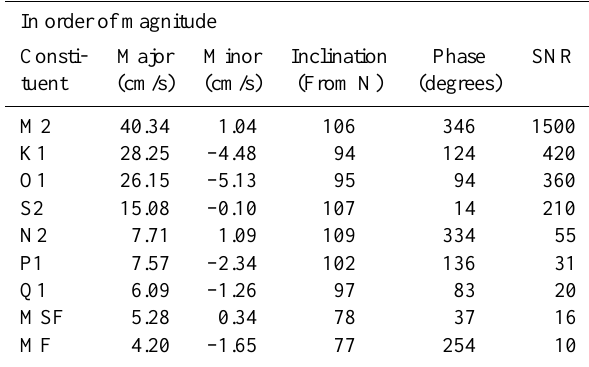
Table 2. Ellipse parameters for the vertically averaged tidal